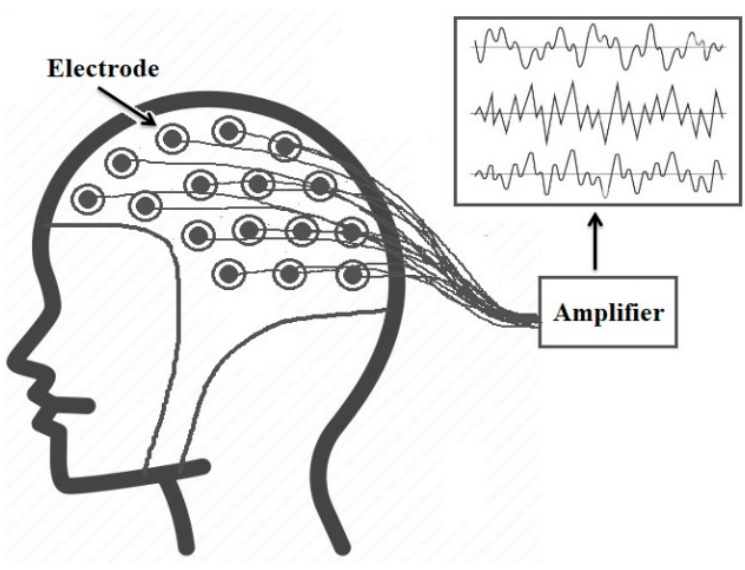
Figure 2. EEG recording [4].